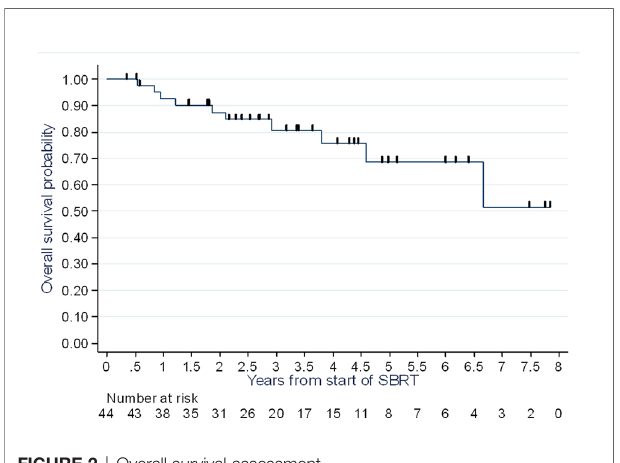
FIGURE 2 | Overall survival assessment.